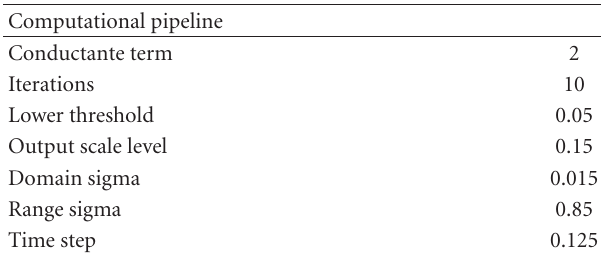
Table 6: Tables of required constraints for contour extraction of pathological features.